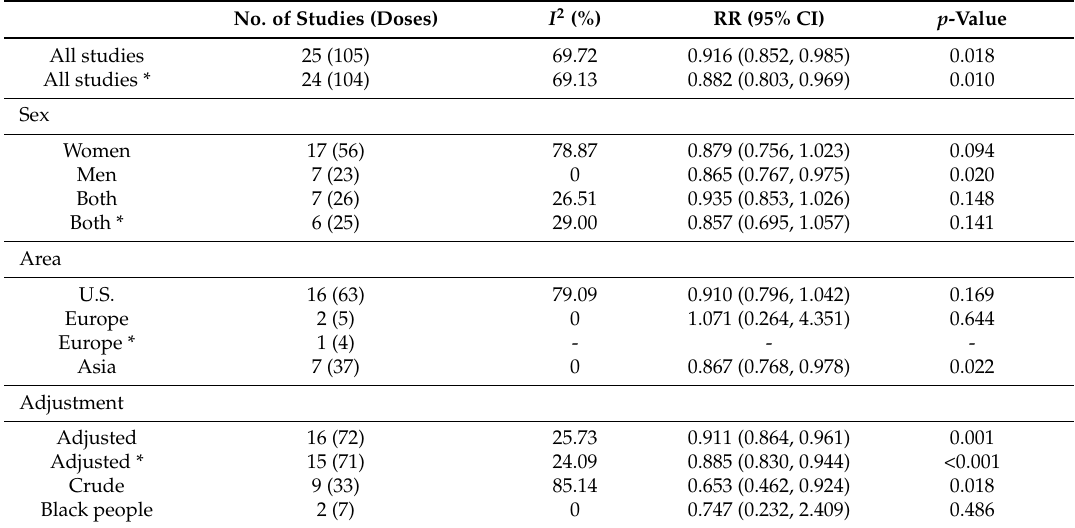
Table 3. Estimated RRs for T2D incidence per 100 mg/day increment in dietary magnesium intake, adjusted for age and BMI.